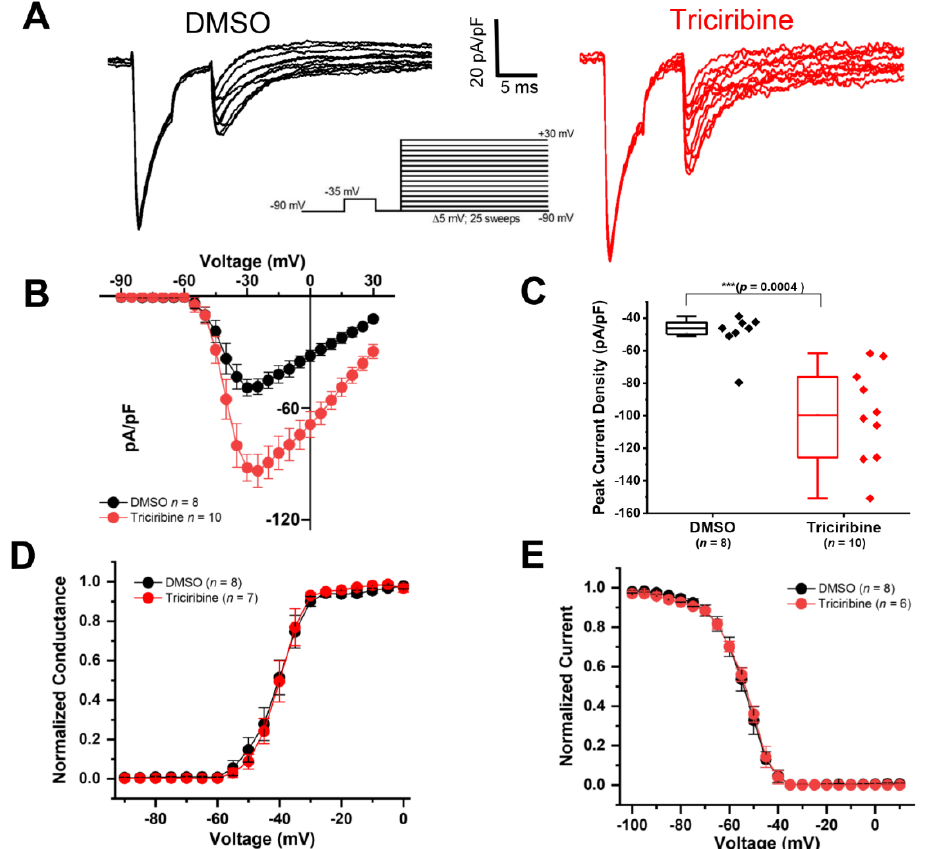
Figure 2. Pharmacological inhibition of Akt increases I Na densities in CA1 hippocampal pyramidal neurons. ( A ) Representative traces of I Na currents recorded from hippocampal neurons treated for 60 min either with DMSO (black) or triciribine 20 µ M (red). ( B ) Current–voltage relationship showing increased peak I Na current densities in triciribine-treated hippocampal pyramidal neurons. ( C ) Peak current density at voltage step of − 10 mV in DMSO ( n = 8) and triciribine-treated ( n = 10) hippocampal neurons. A 60 min treatment with triciribine increased peak sodium current density (*** p = 0.0004 with Student’s t -test). ( D , E ) Voltage dependence of I Na activation ( D ) and steady-state inactivation ( E ) of pyramidal cells from DMSO or triciribine-treated hippocampal slices. Treatment with triciribine did not affect neither the voltage dependence of I Na activation nor steady-state inactivation. Box plot shows: Range (Perc 25, 75), Mean, Median, Min, and Max. Results are summarized in Table 2. CA1 pyramidal neurons from slices treated with vehicle (DMSO) displayed an average peak I Na density for the second test pulse of − 49.5 ± 4.5 pA/pF ( n = 8), whereas 20 µ